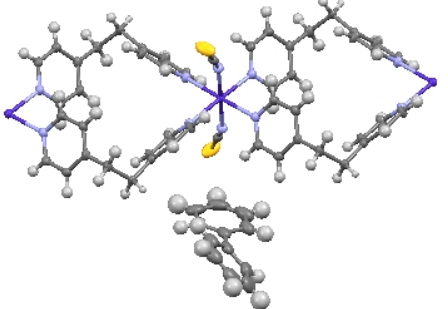
Figure 1. ORTEP drawing of [[Fe(NCS) 2 (bpa) 2 ] · biphenyl] n .